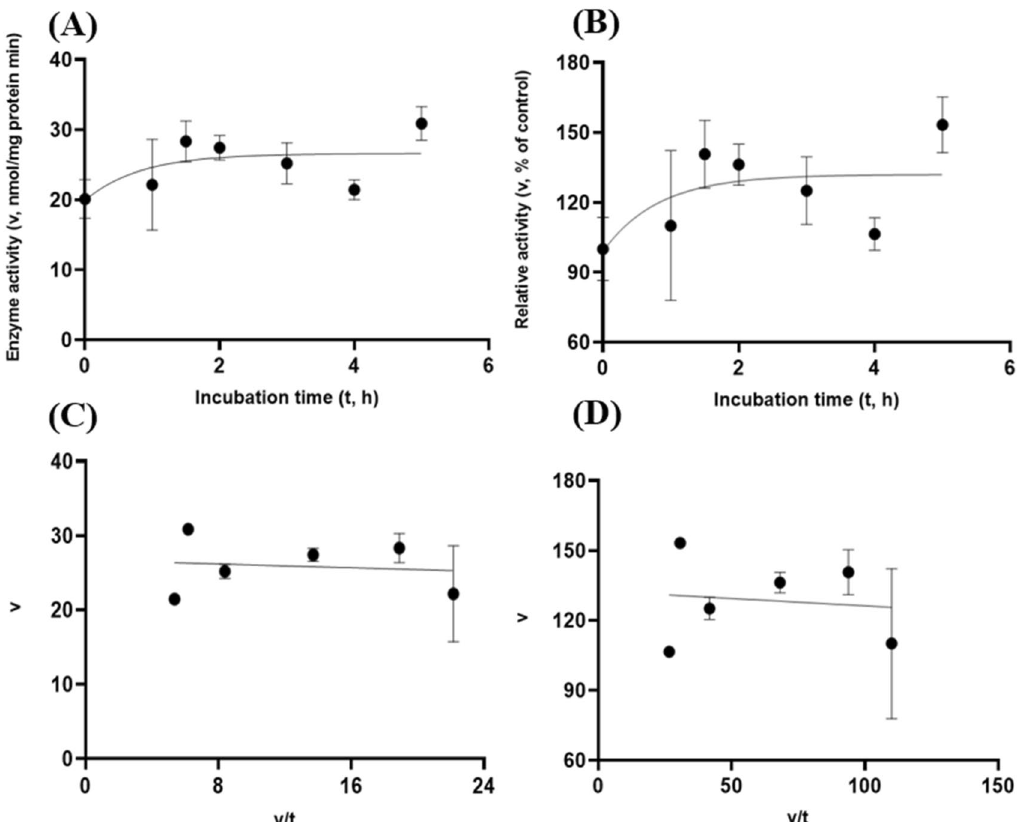
Figure 9. Experiment-2 of the gastric acidic pH and pepsin (274 U/mL) effects (with describing model parameter estimates ± SE ) on GH5-tCel5A1 activity over a 5-h period after the gastric pH and pepsin buffer being mixed with the crude GH5-tCel5A1 enzyme preparation for incubation at the resulting mixture pH = 3.5 and pepsin at 274 U/mL prior to further incubation for measuring cellulase activity with the carboxymethyl cellulose (CMC) substrate buffer in presence of dithiothreitol (DTT) (5 mM) and N 2 gas purging for 15 min at 37 °C. (A) Exponential plot of the inhibition kinetic relationship between the GH5- tCel5A1 activity (v, mean ± SE, n = 12at each time point, nmol/mg protein•min) and incubation time (t, h) under the gastric pH = 3.5 and pepsin (274 U/mL) conditions established according to the exponential response model as: Y = 23.156 ( ± 2.157 ) e ( − x ) , P < 0.0001 for the initial residual tCel5A1 activity estimate; and P = 0.228 for the rate constant estimate; R 2 = 0.072 , n = 84; and alternatively, according to the linear response model established as y = 23.084 ( ± 2.254 ) + 0.949 ( ± 0.783 ) x , P < 0.0001 for the intercept; and P = 0.229 for the slope, r 2 = 0.072 , n = 84; (B) Exponential plot of the inhibition kinetic relationship between the relative GH5-tCel5A1 activity (v, mean ± SE, n = 12at each time point, % of the control group measured (100.000 ± 19.716) at the 0-min exposure to the gastric pH-3.5 and pepsin-274 U/mL incubation) and incubation time (t, h) under the gastric pH 3.5 and pepsin (274 U/mL) conditions according to the exponential response model established as: Y = 115.000 ( ± 10.715 ) e ( x ) , P < 0.0001 for the initial residual GH5- tCel5A1 activity estimate; and P = 0.228 for the rate constant estimate, R 2 = 0.07 , n = 84; and alternatively, according to the linear response model established as y = 114.600 ( ± 11.193 ) + 4.711 ( ± 3.891 ) x , P < 0.0001 for the intercept; and P = 0.229 for the slope, r 2 = 0.072 , n = 84; (C ) the Eadie-Hofstee linear plot between the tCel5A1 enzyme activity (v, mean ± SE, n = 12at each data point, nmol/mg protein•min) and the v/t ratio established as y = 17.432 ( ± 1.455 ) + 0.703 ( ± 0.086 ) x , P < 0.0001 for all parameter estimates, r 2 = 0.551 , n = 72; and (D ) the Eadie-Hofstee linear plot between the relative GH5-tCel5A1 enzyme activity (v, mean ± SE, n = 12at each data point, % of the control group measured (100.000 ± 19.716) at the 0-min exposure to the gastric pH-3.5 and pepsin-274 U/mL incubation) and the v/t ratio established as y = 86.577 ( ± 7.228 ) + 0.703 ( ± 0.086 ) x , P < 0.0001 for all parameter estimates; r 2 = 0.551 , n =